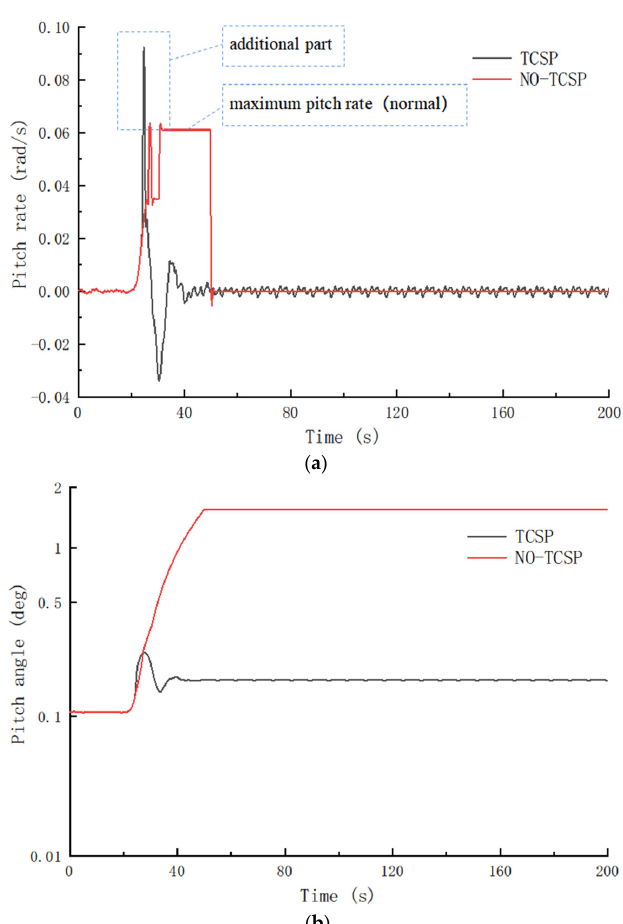
Figure 5. Rotor speed comparison.